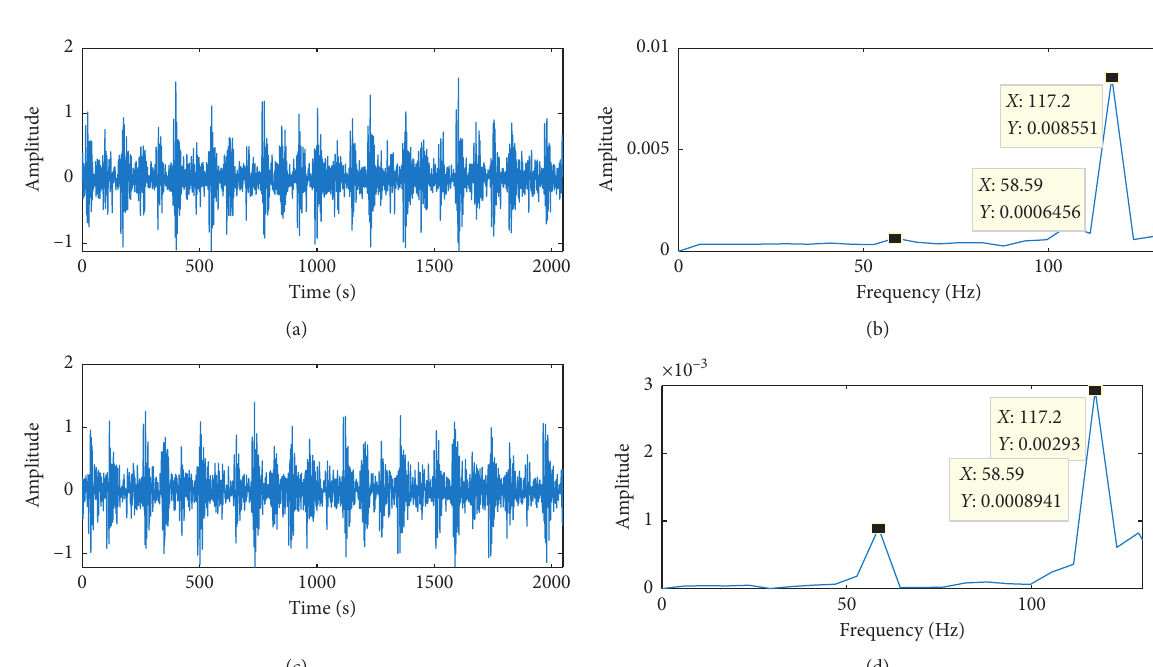
Figure 6: BF2 FFTresults by using different datasets; here, the unit of the x -axis is second. (a) Original signal-dataset A-BF2. (b) Frequency domain-A-BF2. (c) Original signal-dataset B-BF2. (d) Frequency